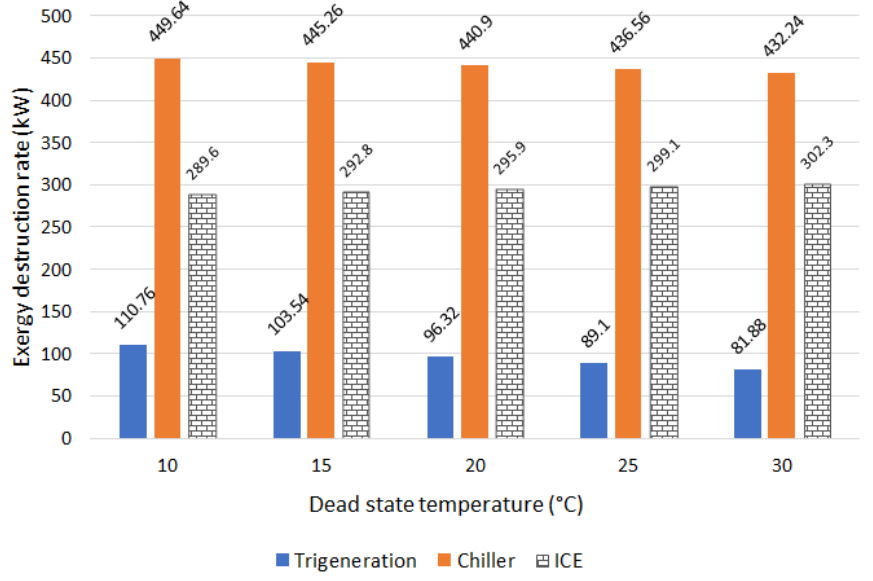
Figure 3. Dead state temperature vs. exergy destruction.